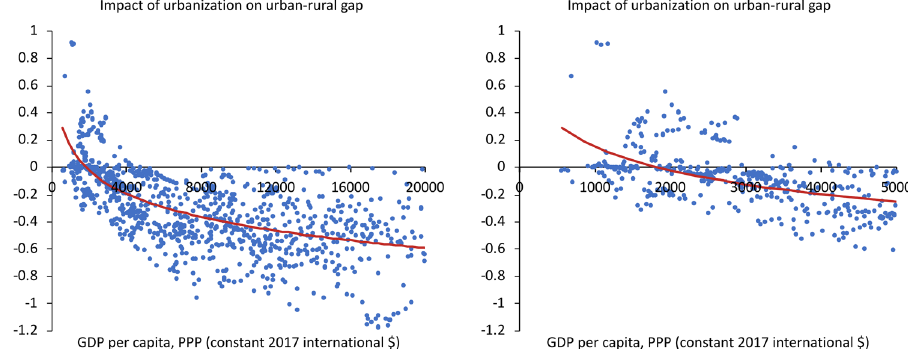
Fig. 4 GDP per capita and the impact of urbanization on the urban-rural gap. This plots the impacts of urbanization on the urban-rural gap using 1990 – 2017 data from 90 economies. Contrary to our initial expectation, it is surprising to fi nd that urban-rural migration or urbanization before GDP per capita reaches USD 2000 (2011 PPP-adjusted in constant 2017 international $) leads to an enlargement of the urban-rural gap but the impact of urbanization becomes benign thereafter. Source: Authors ’ calculations (see